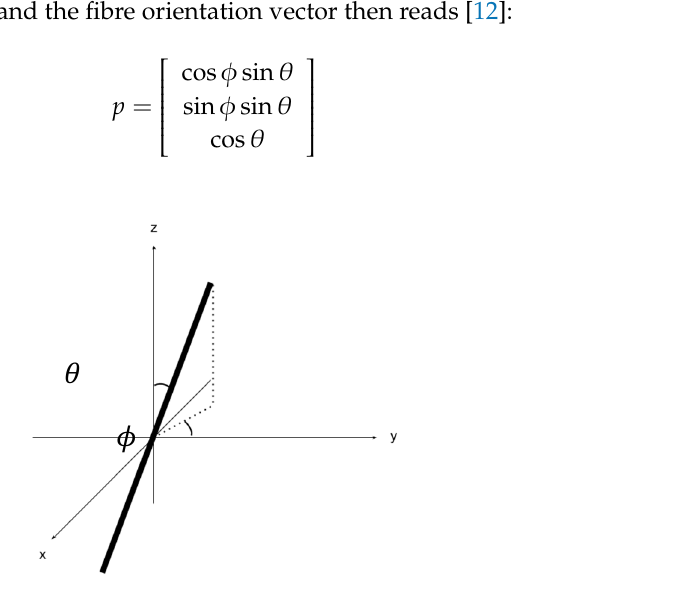
Figure 1. Angular components of the spherical coordinates used to describe fibre orientation.